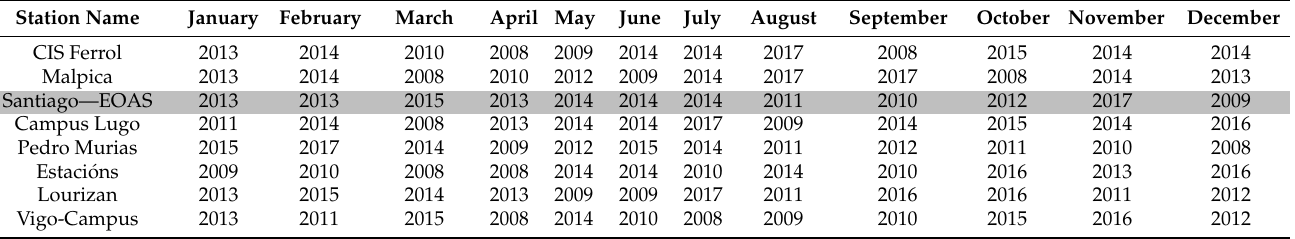
Table 8. Typical meteorological years according to Sandia Laboratories methodology for the 8 stations, period